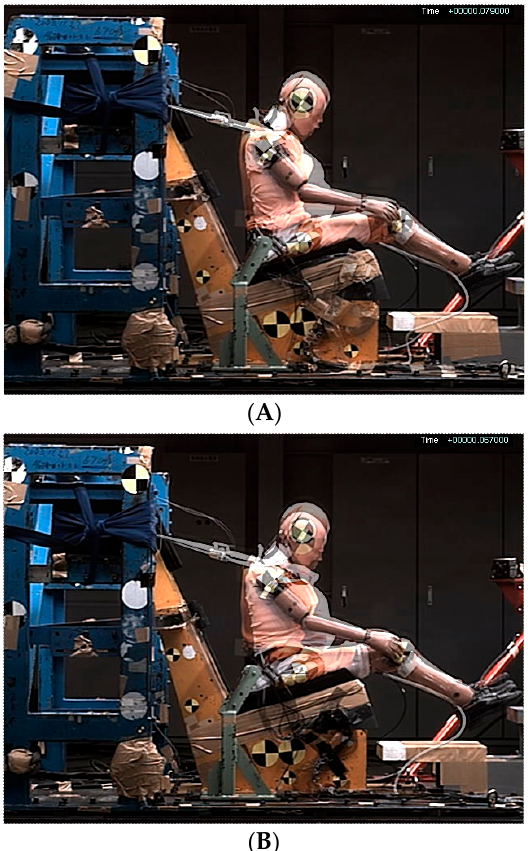
Figure 1. ( A ) Kinematics of the MAMA IIB and Hybrid III at a delta-V of 29 km/h in tests 1 and 2; ( B ) kinematics of the MAMA IIB and Hybrid III at a delta-V of 48 km/h in tests 3 and